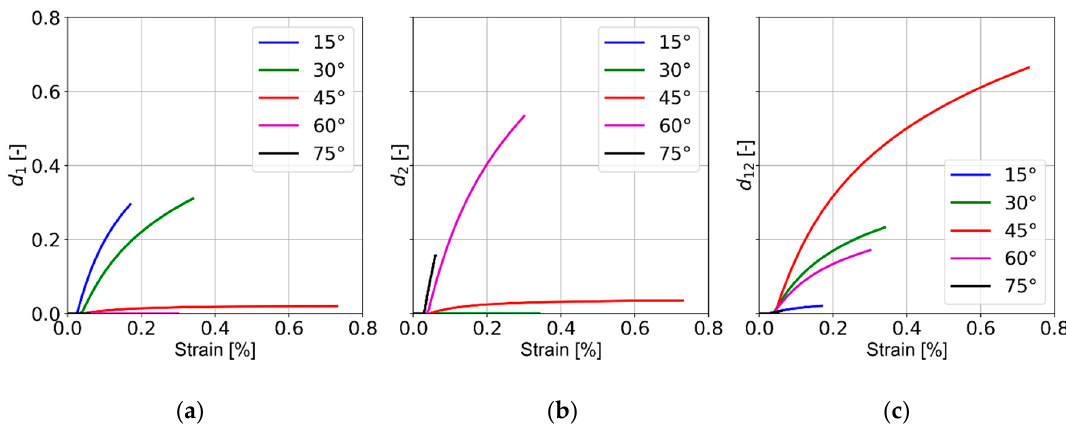
( b ) Figure 4. Comparison between stress–strain curves obtained from simulation (broken line) and tensile tests (solid line) with different fiber orientations: ( a ) C/C–SiC; ( b ) WHIPOX™. In the case of C/C–SiC, the simulation results are in good agreement with the experimental results apart from the winding angle of ±60°. If the global load on a sample with a ±60° fiber orientation is resolved into local stress components, 𝜎 (cid:2870) and 𝜎 (cid:2869)(cid:2870) are present in the material with a small contribution of 𝜎 (cid:2869) . This phenomenon can be explained with the help of Figures 5 and 6. In Figure 5, the development of damage components ( 𝑑 (cid:2869) , 𝑑 (cid:2870) and 𝑑 (cid:2869)(cid:2870) ) with respect to the global loading strain is plotted. In the case of ±15°, the load is mostly carried by fibers and damage is noticed only in 1-direction ( 𝑑 (cid:2869) ). 𝑑 (cid:2870) is zero and there is a small amount of 𝑑 (cid:2869)(cid:2870) present in the sample. On the other hand, in the case of ±75°, the damage is only in the matrix-dominant 2-direction where only 𝑑 (cid:2870) plays